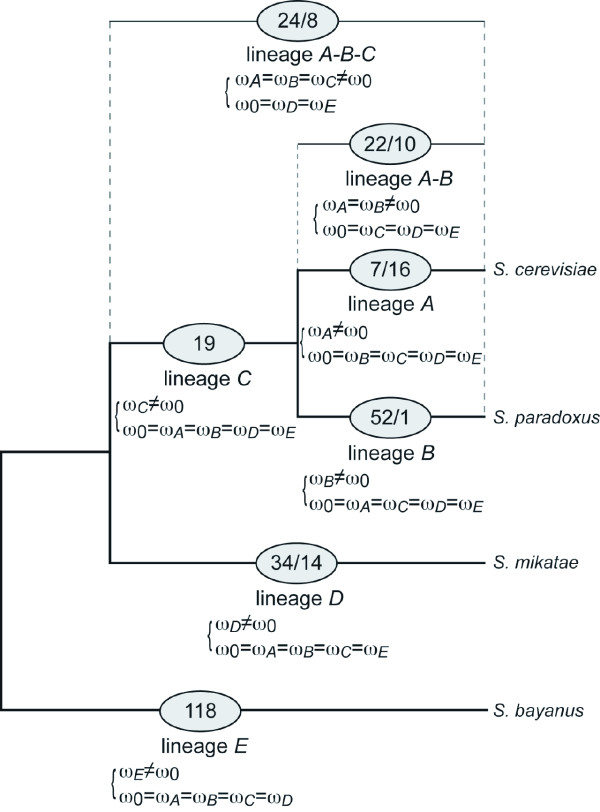
The evolutionary models tested in the likelihood ratio tests and the numbers of the genes with rate changes, rate accelerations and rate decelerations for each lineage. Evolutionary models in which ω (dN/dS ratio) on a certain lineage (ωx) assumed to be different from ω on other background lineages (ω0) are shown below each branch. ωx is the nonsynonymous/synonymous substitution rate ratio in the lineage X. The numbers of the genes with evolutionary rate accelerations and rate decelerations estimated by the likelihood ratio tests are shown in the circles drawn on each branch. For the lineage C and E, the numbers of the genes with evolutionary rate changes are shown.